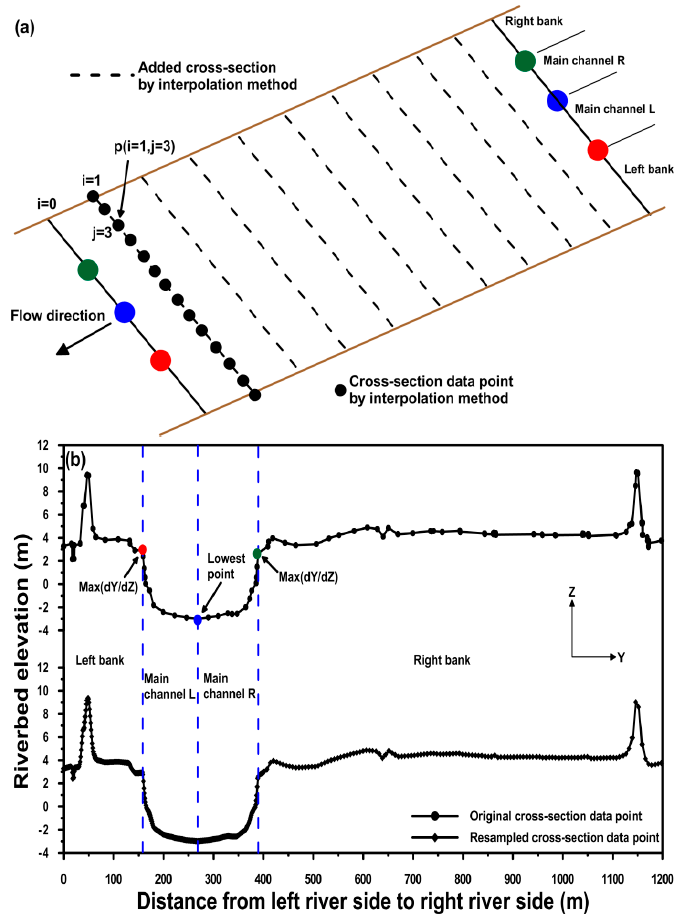
Figure 2. ( a ) Conceptual diagram of the resampling method (L and R represent the main channel at left part and right part); and ( b ) comparison of the original and resampled cross-sectional data points generated by the linear interpolation method.